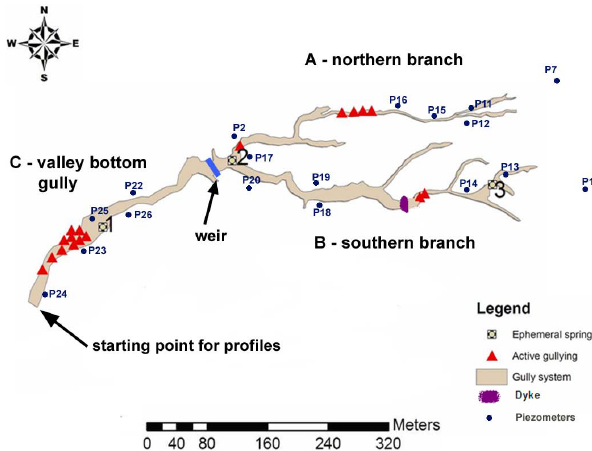
Fig. 3. The Debre-Mawi gully extent generated by handheld GPS tracking. Active erosion areas are indicated by triangles. Ephemeral springs and piezometer locations are shown as